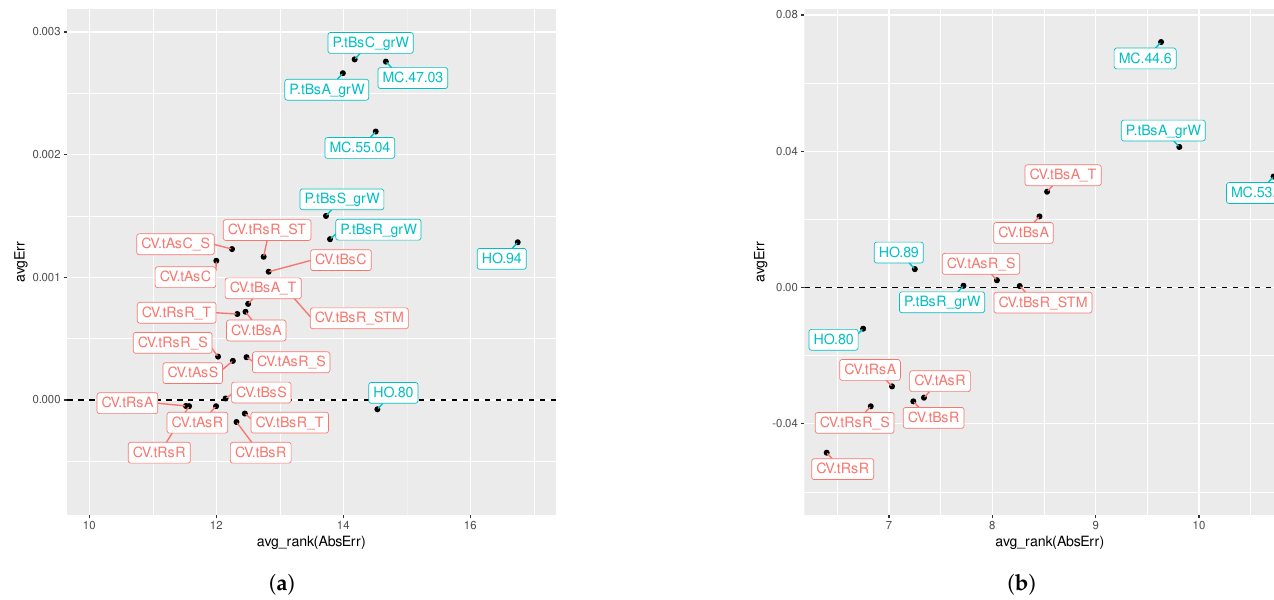
Figure 16. Average error against average rank of absolute errors for ( a ) artificial; and ( b ) real-world data sets. Procedures below the dashed lined tend to be optimistic in their error estimates. Lower ranks indicate more accurate estimates in terms of absolute